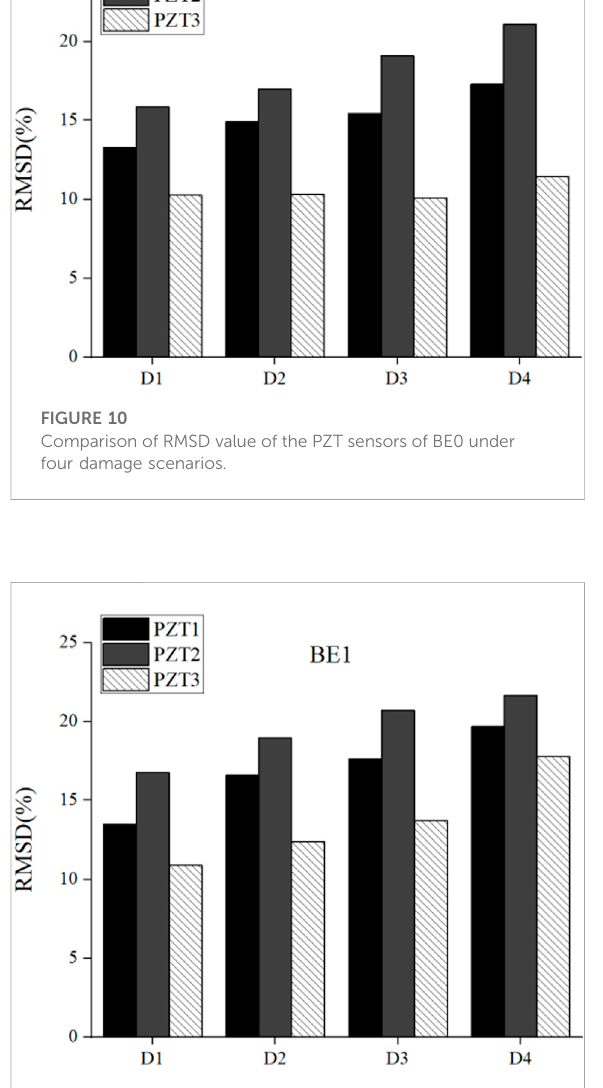
FIGURE 11 Comparison of RMSD values of the PZT sensors of BE1 under four damage